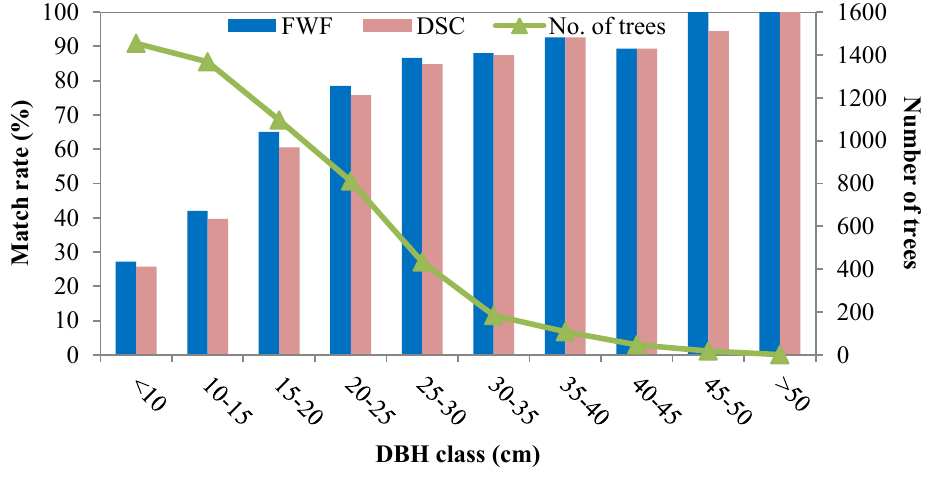
Figure 6. The DBH distribution of correctly detected trees for DSC and FWF data sets.